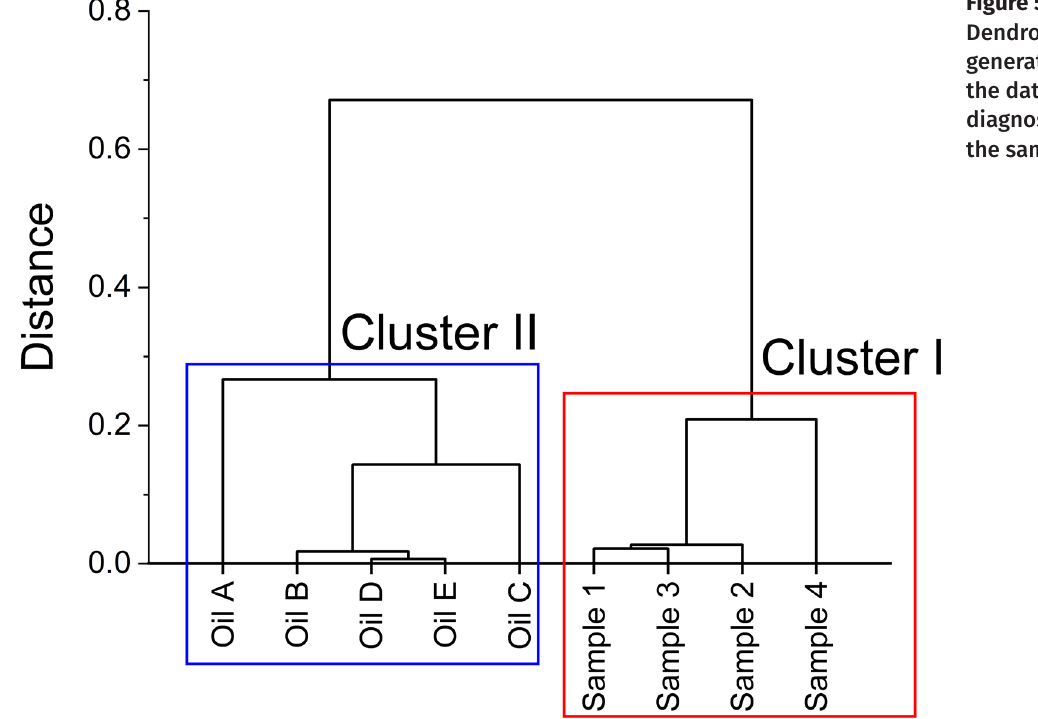
Figure 5 . Dendrogram generated from the data for the diagnostic ratios of the